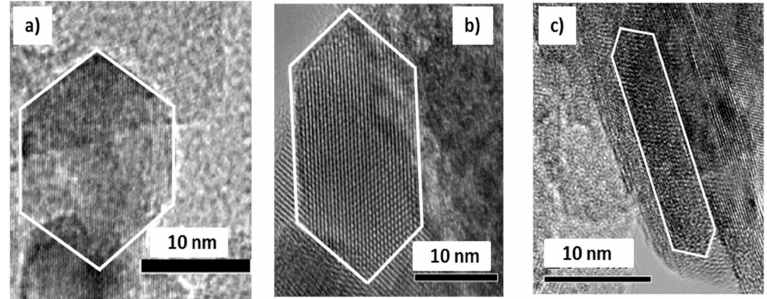
Figure 1. XRD patterns of TiO 2 materials used in the present study: 1—TiO 2 -1, 2—TiO 2 -2, 3—TiO 2 -3. The XRD peaks used for the calculation of crystals’ width and length are denoted by solid and open circles, respectively.